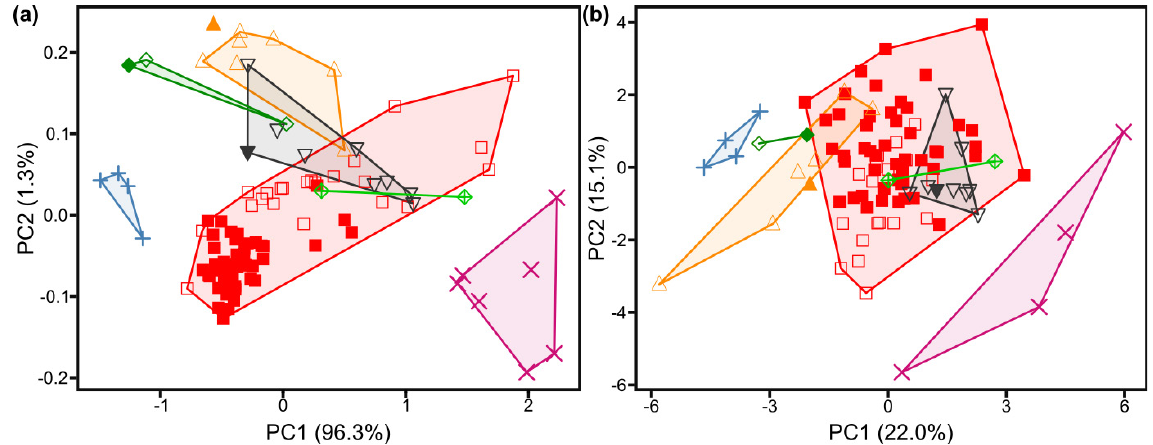
Fig. 5. Scatterplots of PC2 against PC1 of (a) the PCA (n = 105) on 24 log-transformed measurements and (b) the PCA (n = 95) on 15 meristics. Specimens of group B, the filled squares (■) represent the genetic analysed specimens, the open squares (□) indicate the additional specimens. Specimens of E. alberti (Poll, 1939) (lectotype) (♦), E. alberti (paralectotypes) (◊), specimens from Tshambi ( ), E. cercops (Whitehead, 1960) (holotype) (▲), E. cercops (paratypes) ( ), E. mimus (Boulenger, 1912) (lectotype) (▼), E. mimus (paralectotypes) ( ▼ ), E. perince (Rüppell, 1835) (syntypes) (+) and E. stigmatopygus (Boulenger, 1903) (syntypes) ( ×